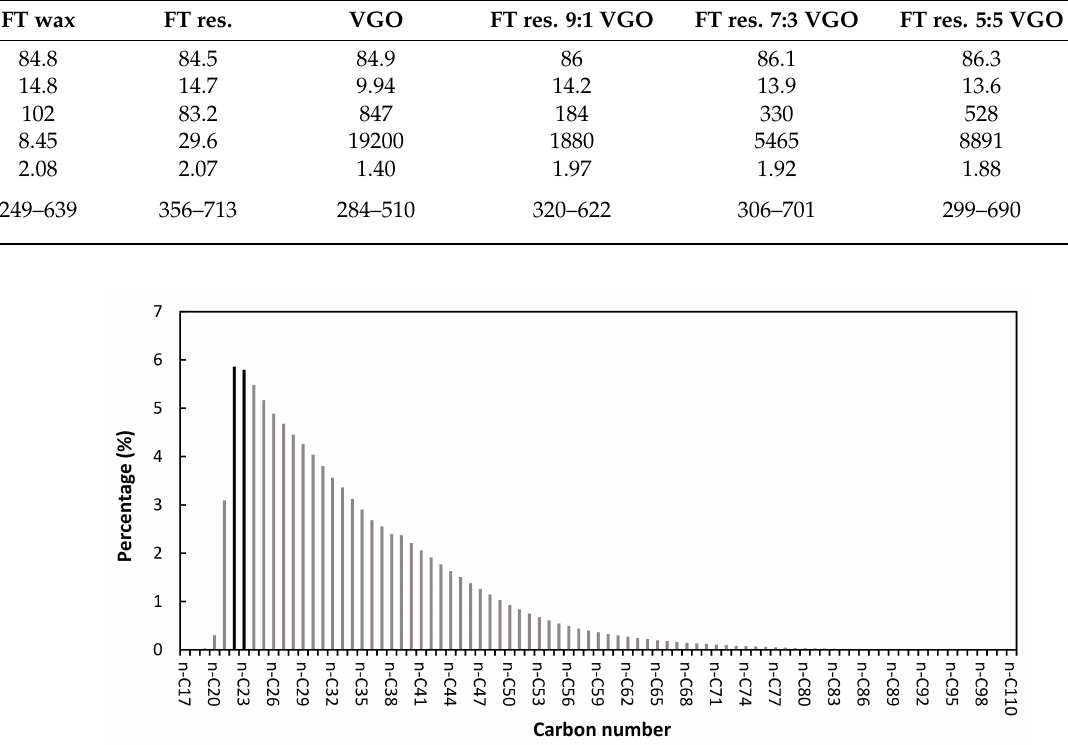
Figure 3. Distribution of hydrocarbons in FT